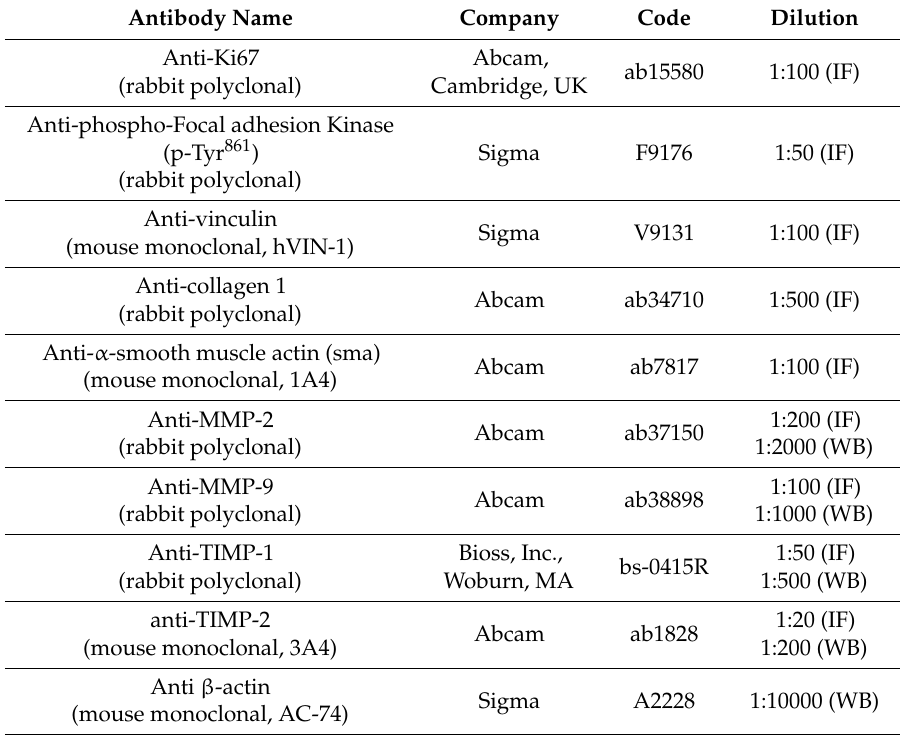
Table 2. Specifications of primary antibodies used for immunofluorescence (IF) and western blotting (WB)